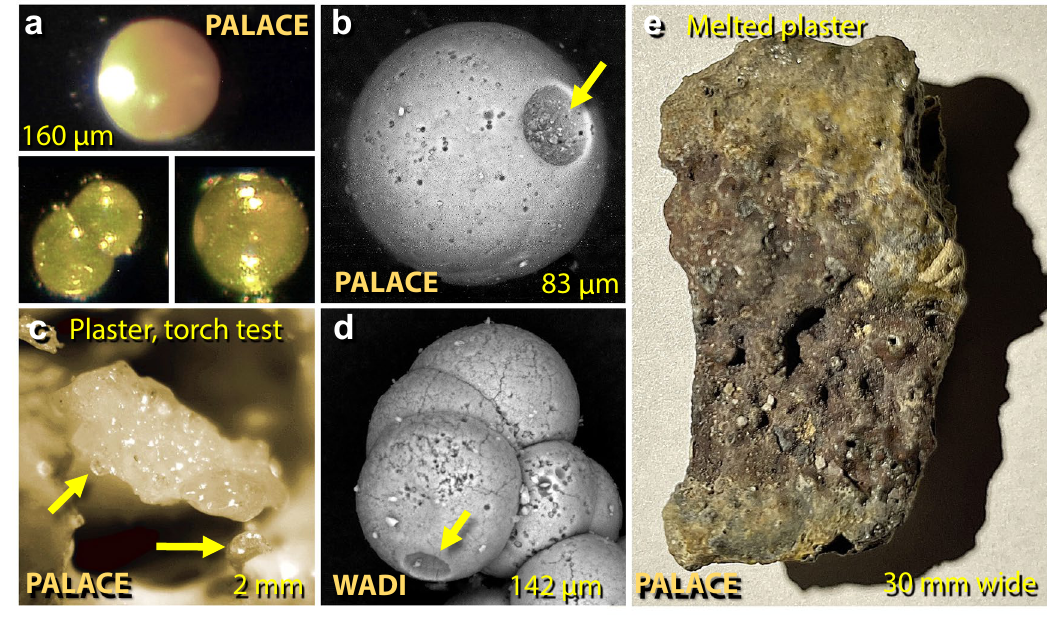
Figure 29. Images of calcium carbonate spherules and melted plaster from TeH. ( a ) Photomicrographs of translucent, amber-colored CaCO 3 spherules from the destruction layer in the palace. ( b ) SEM image of 83-µm carbonate spherule with impact or outgassing crater at arrow. ( c ) Photomicrograph of ~ 2-mm-wide piece of partially melted palace plaster from oxygen/propylene torch test, showing incipient melting at 1500 °C. Arrows point to hemispheric droplets emerging as spherules. ( d ) 142-µm cluster of 8 carbonate spherules with apparent impact or outgassing crater at arrow. ( e ) 64 × 30 mm piece of melted plaster that broke off the palace wall and became melted. It is composed only of calcium, carbon, and oxygen.